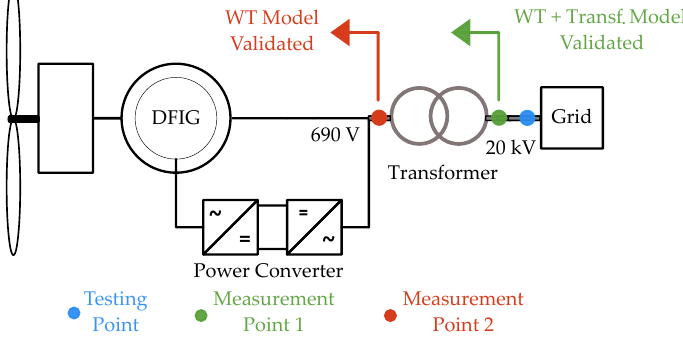
Figure 4. Measurement and testing points for WT validation according to the PVVC.